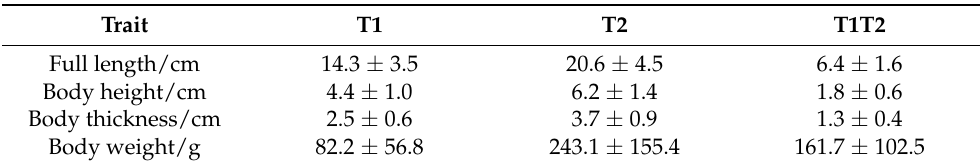
Table 1. Full length, body height, body thickness and body weight of Yellow River carp at the T1, T2 and T1T2